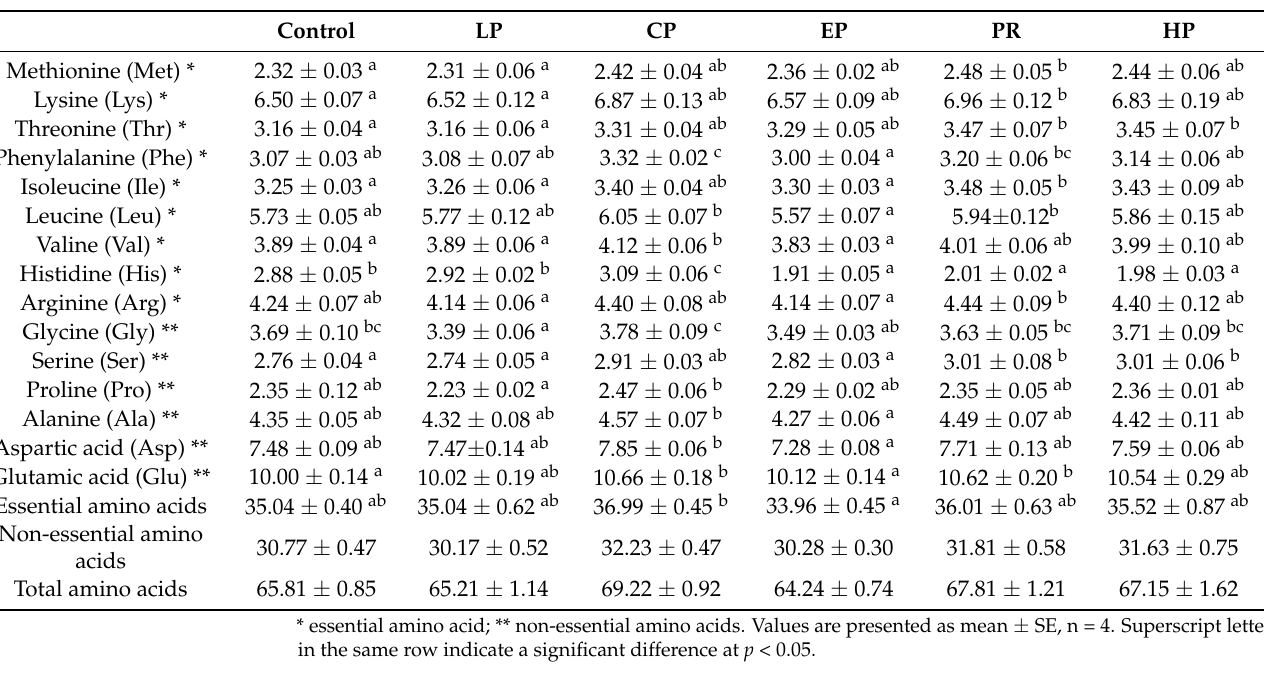
Table 8. Amino acid composition in the dorsal muscle of Oncorhynchus mykiss fed on the experimental diets (% dry matter).